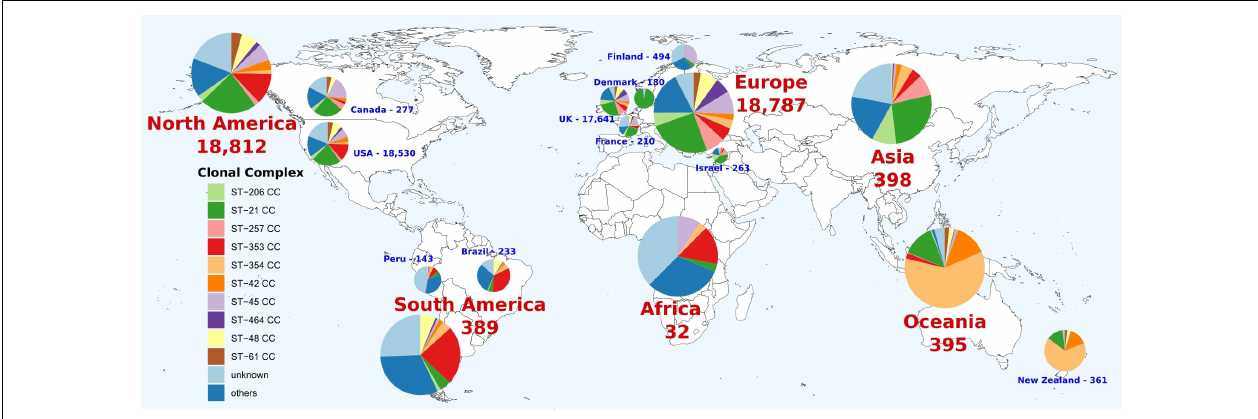
FIGURE 2 | Geographical distribution of C. jejuni clonal complexes (CCs). Only countries with more than 100 genomes were represented. The number indicates the genomes available on the corresponding continent or country. Colors within pie charts represent the percentage of genomes belonging to the main CCs, with low abundant CCs grouped as “others” and genomes with unknown CCs as